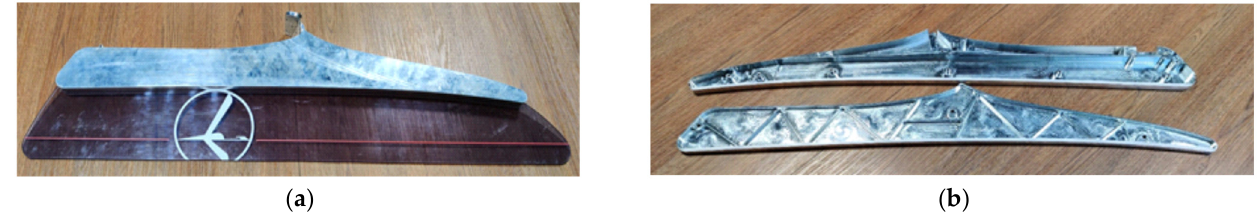
Figure 4. Class-divider part: ( a ) assembled, and ( b ) inside view of the two halves of the class di-